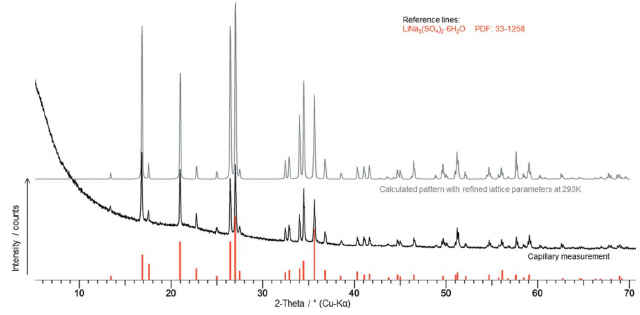
Figure 15 Powder XRD pattern of LiNa 3 (SO 4 ) 2 (cid:2) 6H 2 O recorded from a rotating capillary. Scan rate: 20 sec, steps 0.023 (cid:3) . For comparison, the calculated powder pattern from structural data at 293 K is also shown.